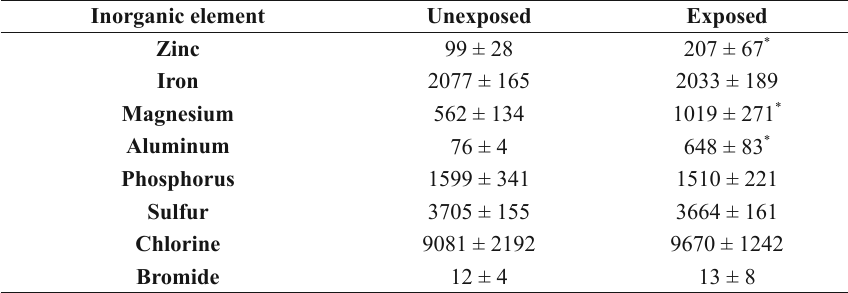
Inorganic element detection by PIXE analyses (ppm; mean values ± standard deviation) in the blood samples of unexposed and exposed groups to pesticides.